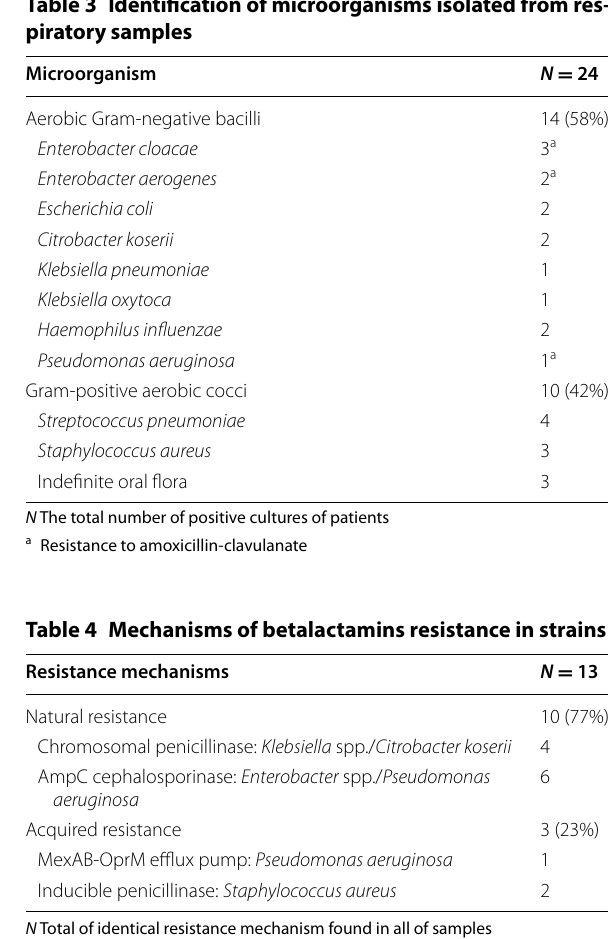
N Total of identical resistance mechanism found in all of samples